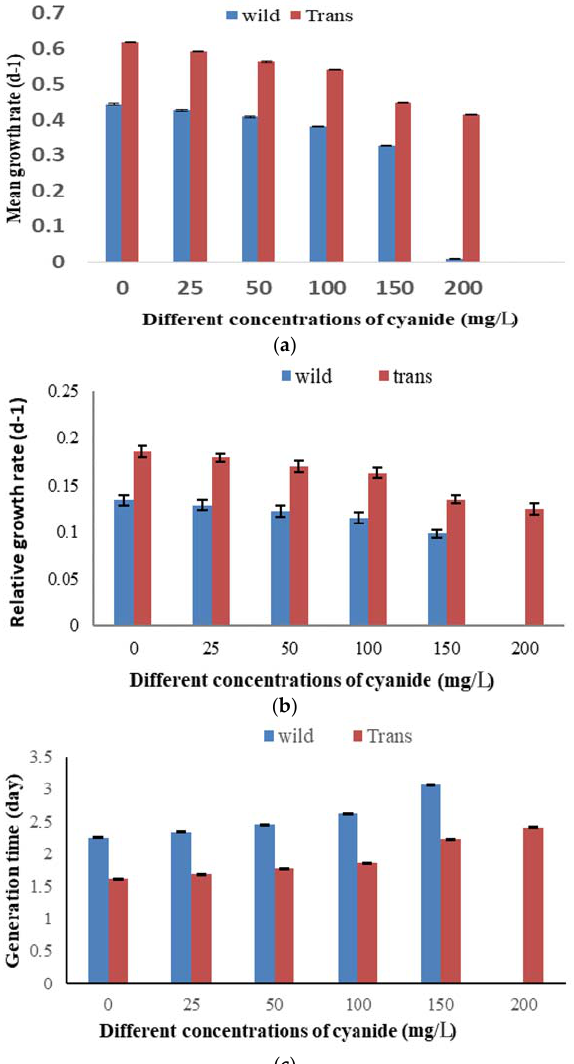
Figure 7. Growth parameters of wild ‐ type and transformed Chlamydomonas reinhardtii under the effect of different KCN concentrations. ( a ) Mean growth rate, ( b ) relative growth rate, ( c ) generation time. Bars are mean ± standard error of three replicates. p < 0.001.